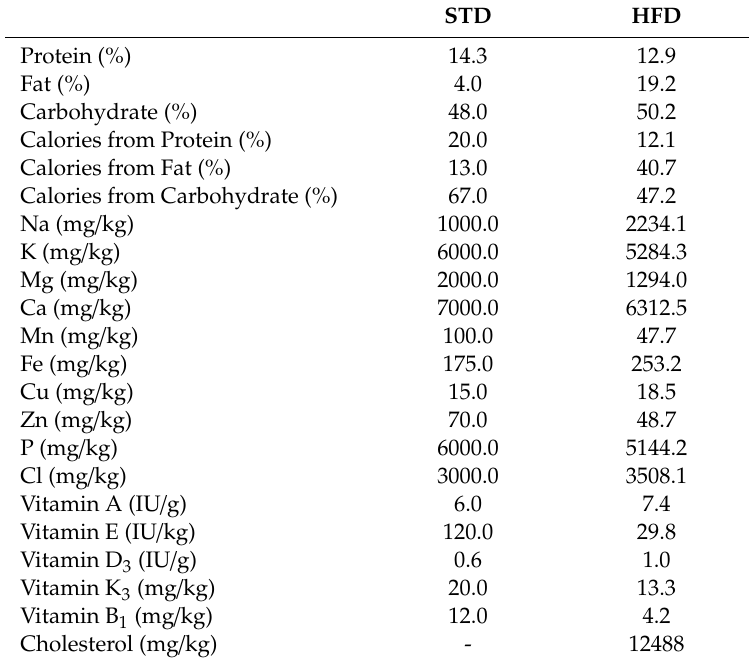
Table 3. Composition of the two diets used: standard diet (STD) and high fat diet